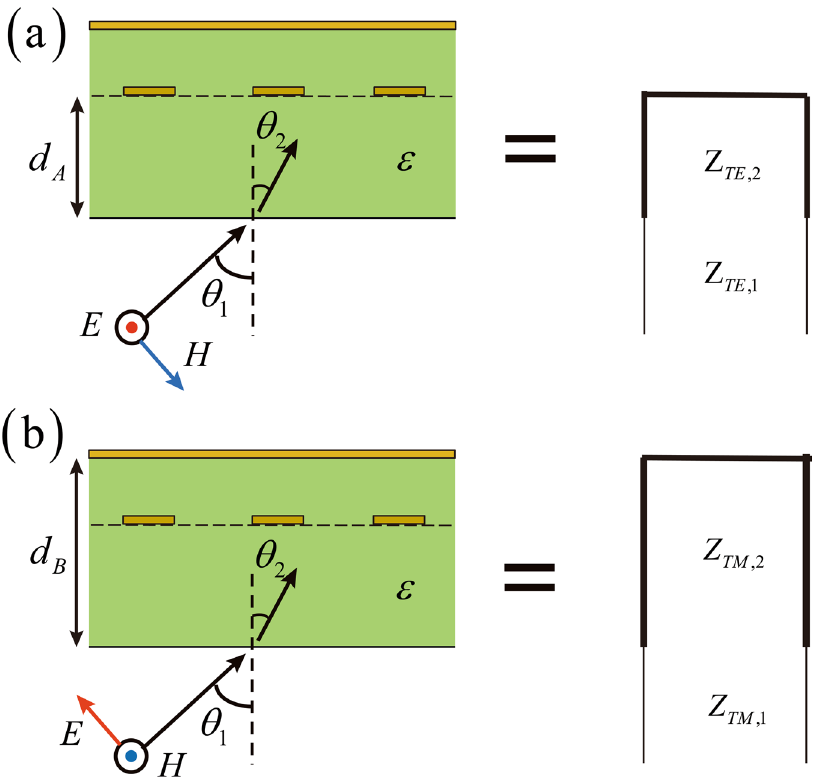
Figure 7. Eigen-mode picture for the general analysis of the proposed broadband half-wave plate. ( a ) Case of TE eigen-mode excitation. ( b ) Case of TM eigen-mode excitation. Note that for genericity the grating wire is positioned away from the middle plane of the dielectric slab and the incident angle is